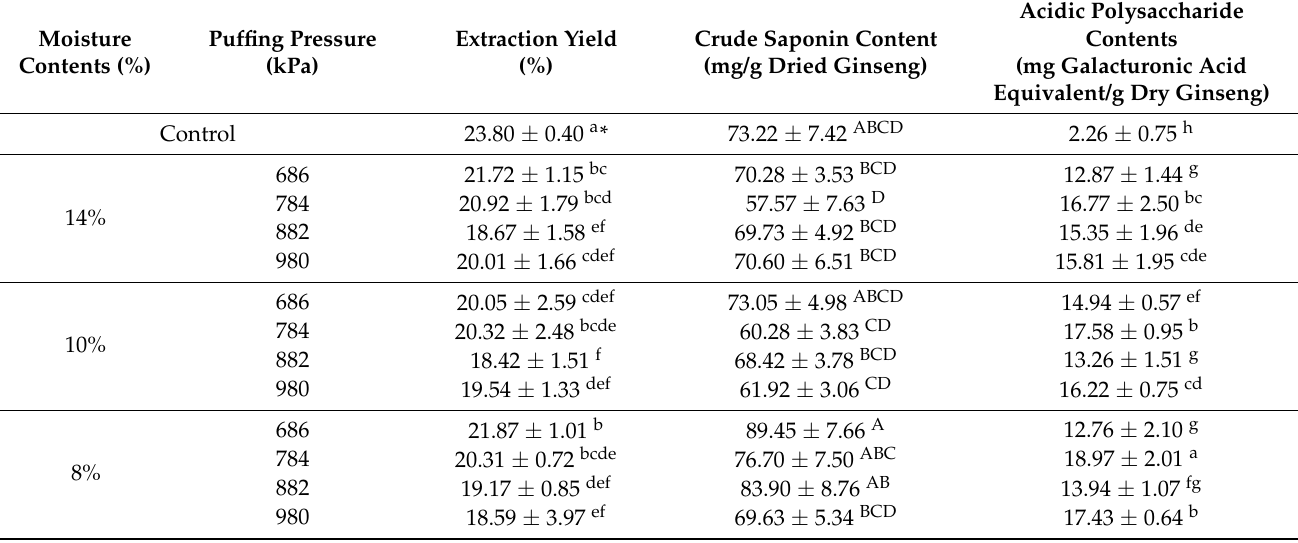
Table 1. Extraction yields, crude saponin contents, and acidic polysaccharide contents of puffed CWPG with different puffing pressure and moisture